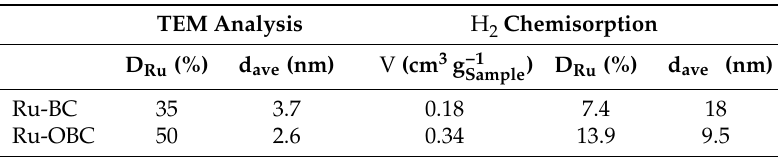
Table 5. TEM and Chemisorption